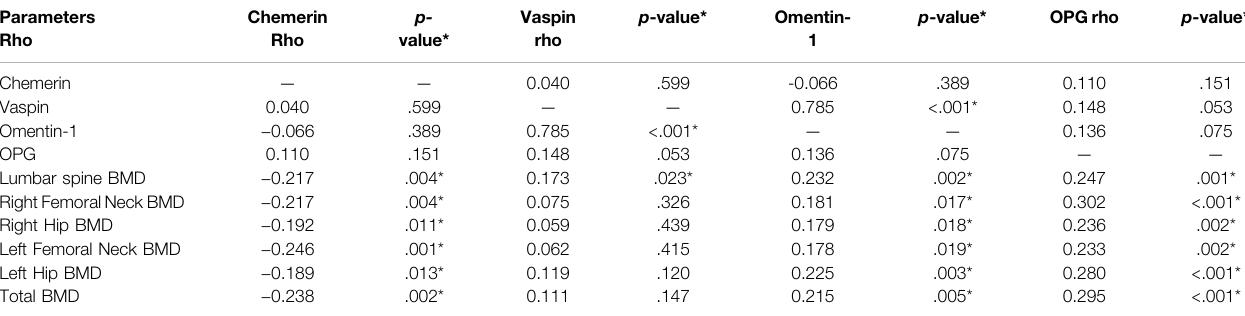
TABLE 2 | Correlation between serum chemerin, vaspin, omentin-1, OPG and BMD in postmenopausal females ( n = 173). Parameters Rho